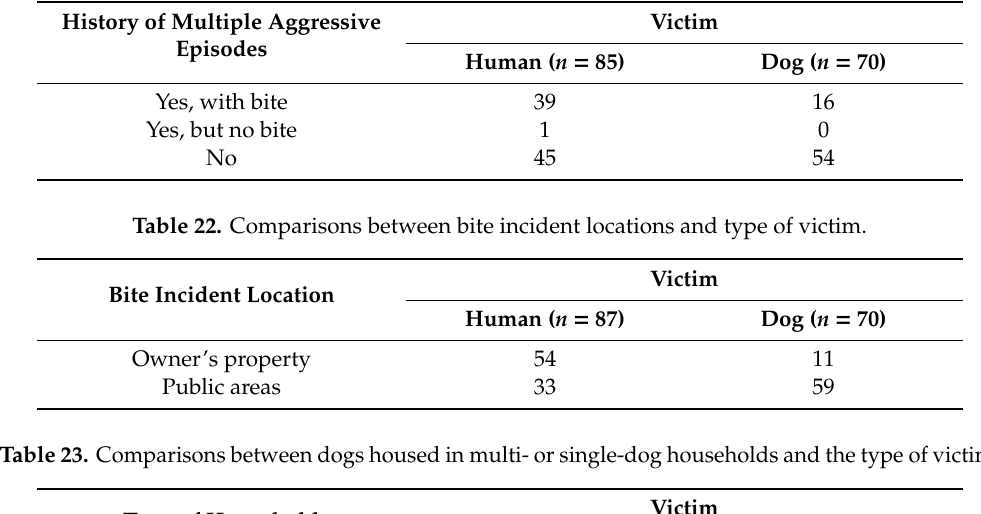
Table 21. Comparisons between the type of victim and history of previous aggressive episodes.